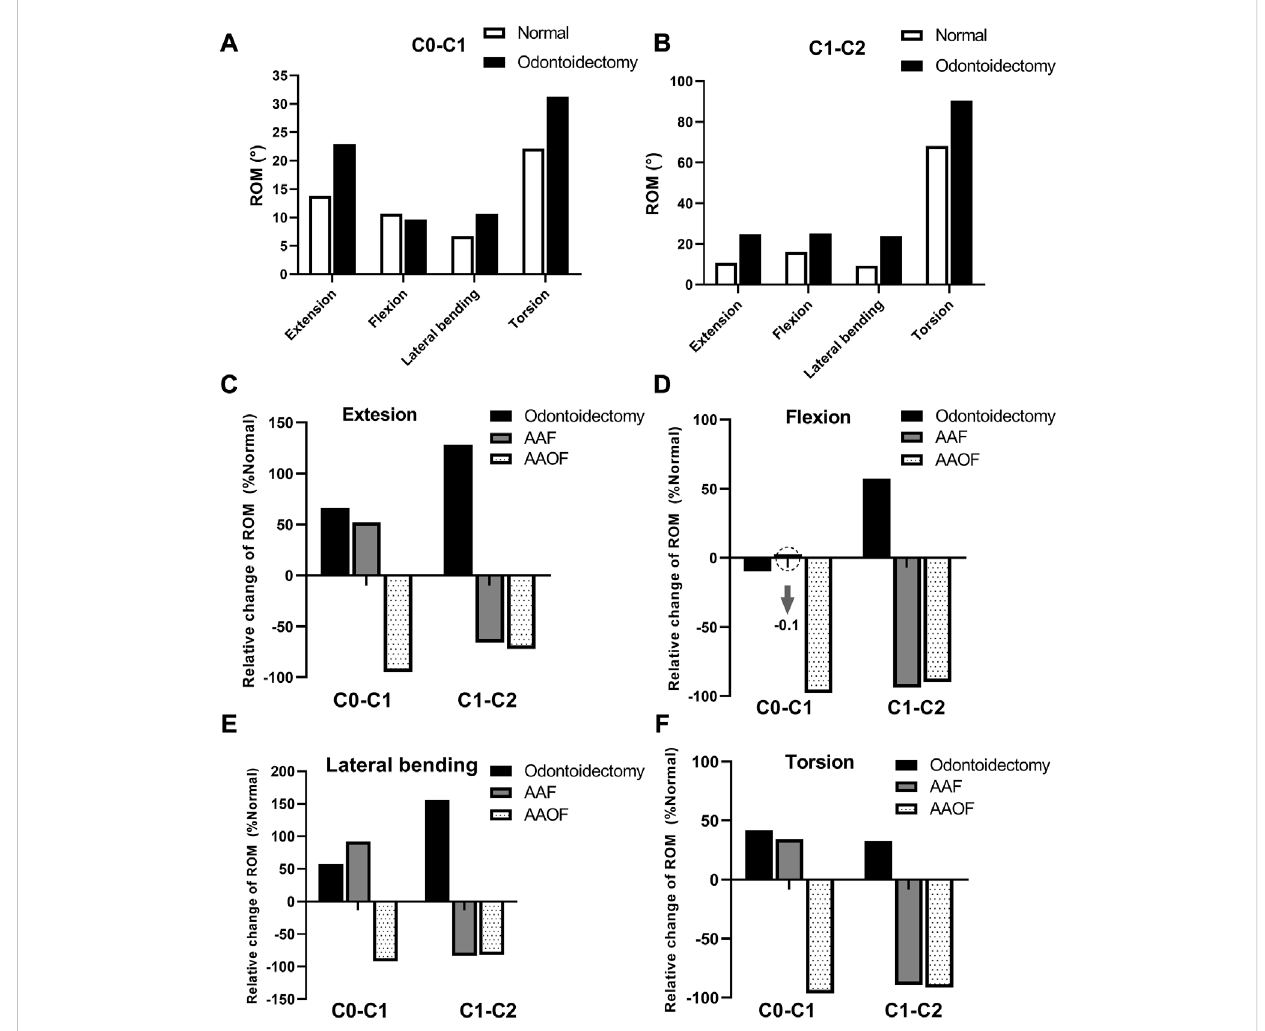
FIGURE 3 The changes of ROM ( ° ) of the three surgical models compared to the normal model at Occiput-C1 and C1-C2 junctions. ROM = range of motion (A,B) presentedtheROM( ° )ofodontoidectomymodelandnormalmodelatOcciput-C1andC1-C2junctions,respectively.Andin (C – F) ,thepercentage change of ROMs for the odontoidectomy, AAF, and AAOF models relative to the normal model were